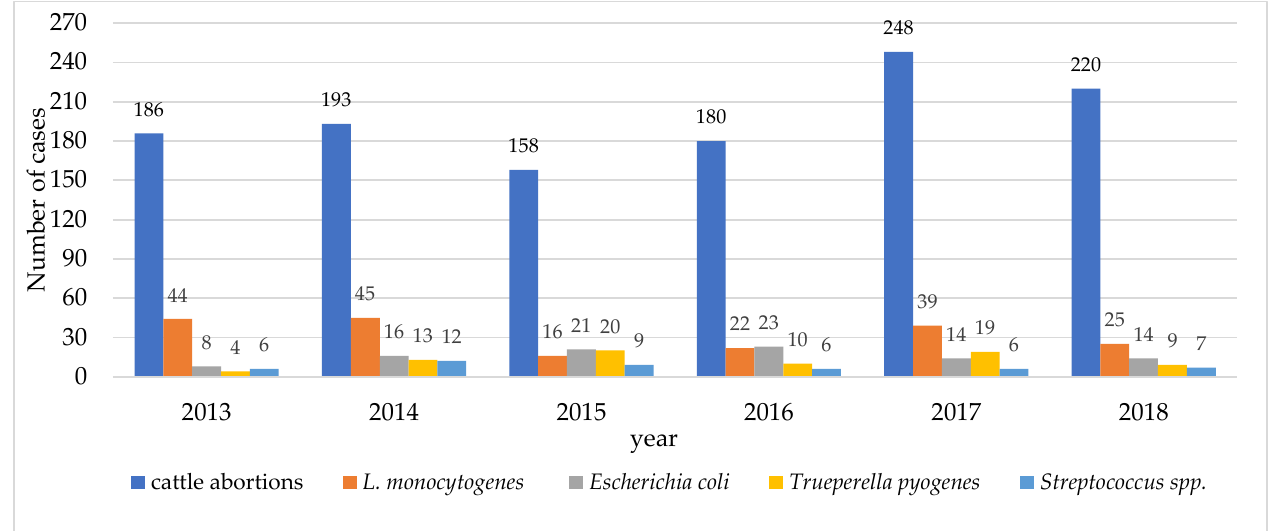
Figure 1. Investigated cattle abortion cases and the most frequently observed pathogens associated with cattle abortions (2013 – 2018).